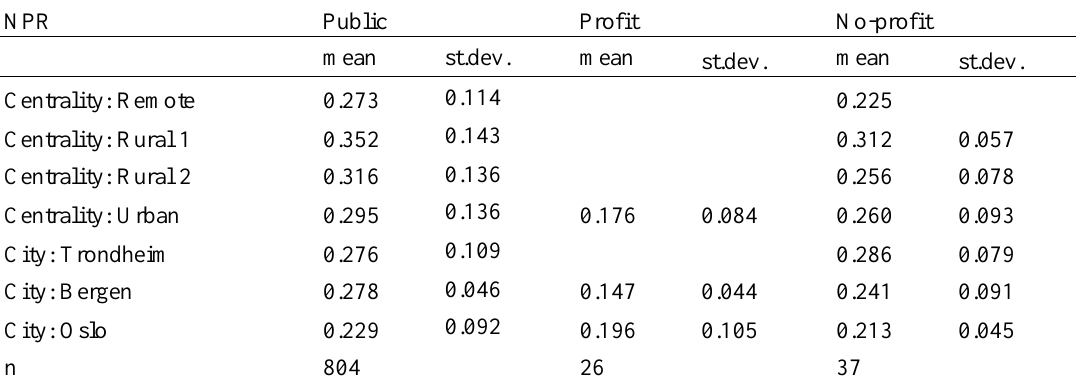
Table 2: Mean and standard deviation of quality of care, by provider category and location (centrality and city) of the institutions NPR Public Profit